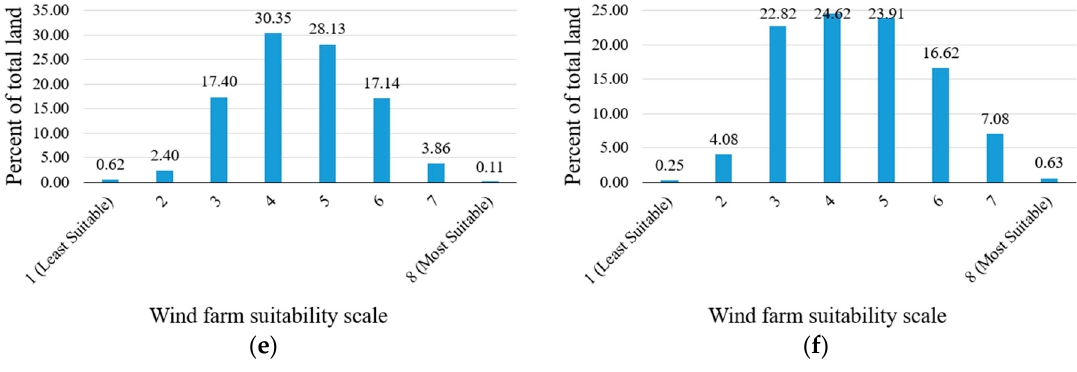
Figure 7. Divisions of South Korean land territory according to different wind farm suitability scales ( a ) Scenario 1 ( b ) Scenario 2 ( c ) Scenario 3 ( d ) Scenario 4 ( e ) Scenario 5 ( f ) Scenario 6.